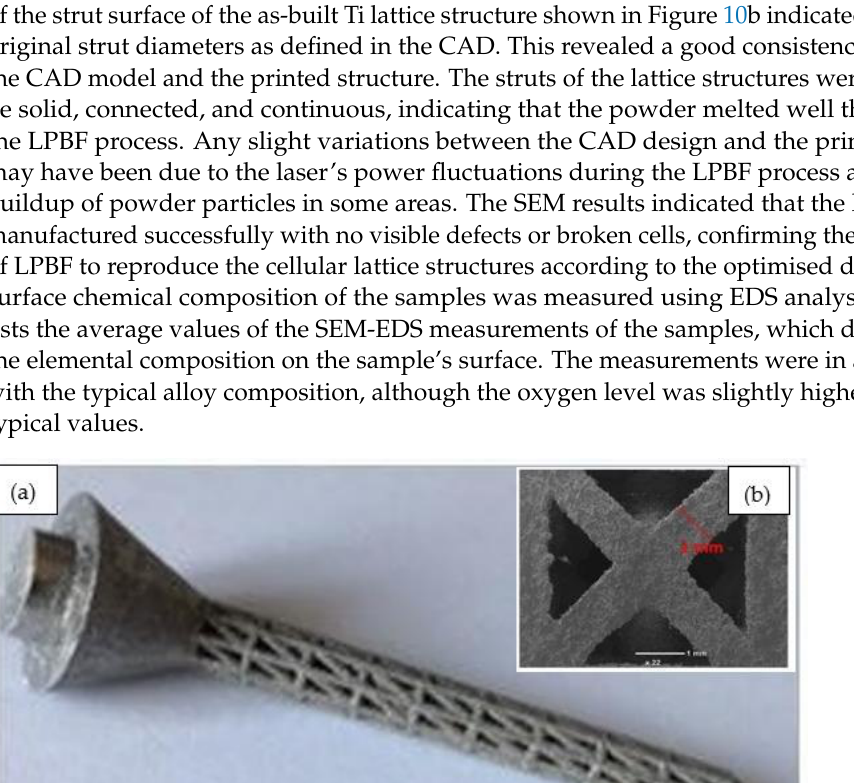
Figure 9. Fracture compression test results for a Ti-6Al-4V LPBF lattice structure with design di- mensions of Lattice 1.